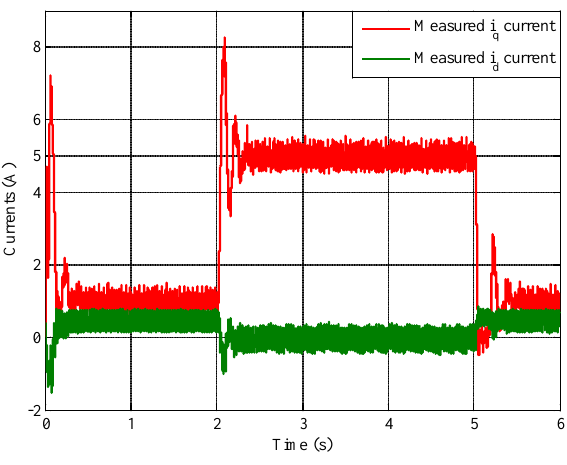
Figure 19. Measured currents